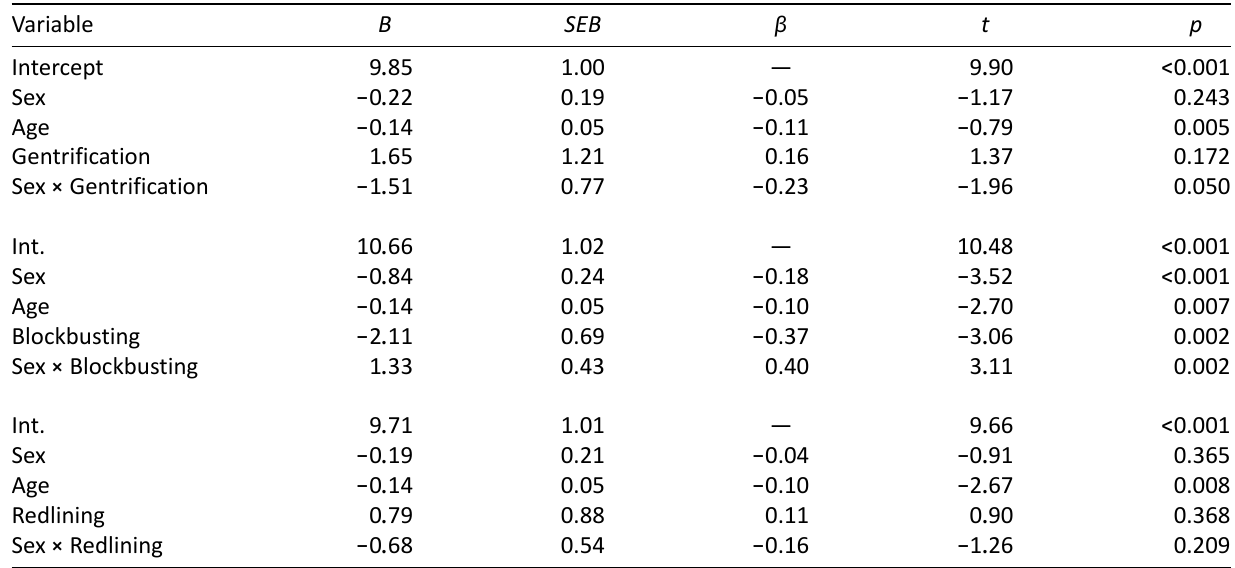
Table 2. Unstandardized and standardized beta weights from the final steps of hierarchical models of discriminatory hous‐ ing practices’ associations with neighborhood